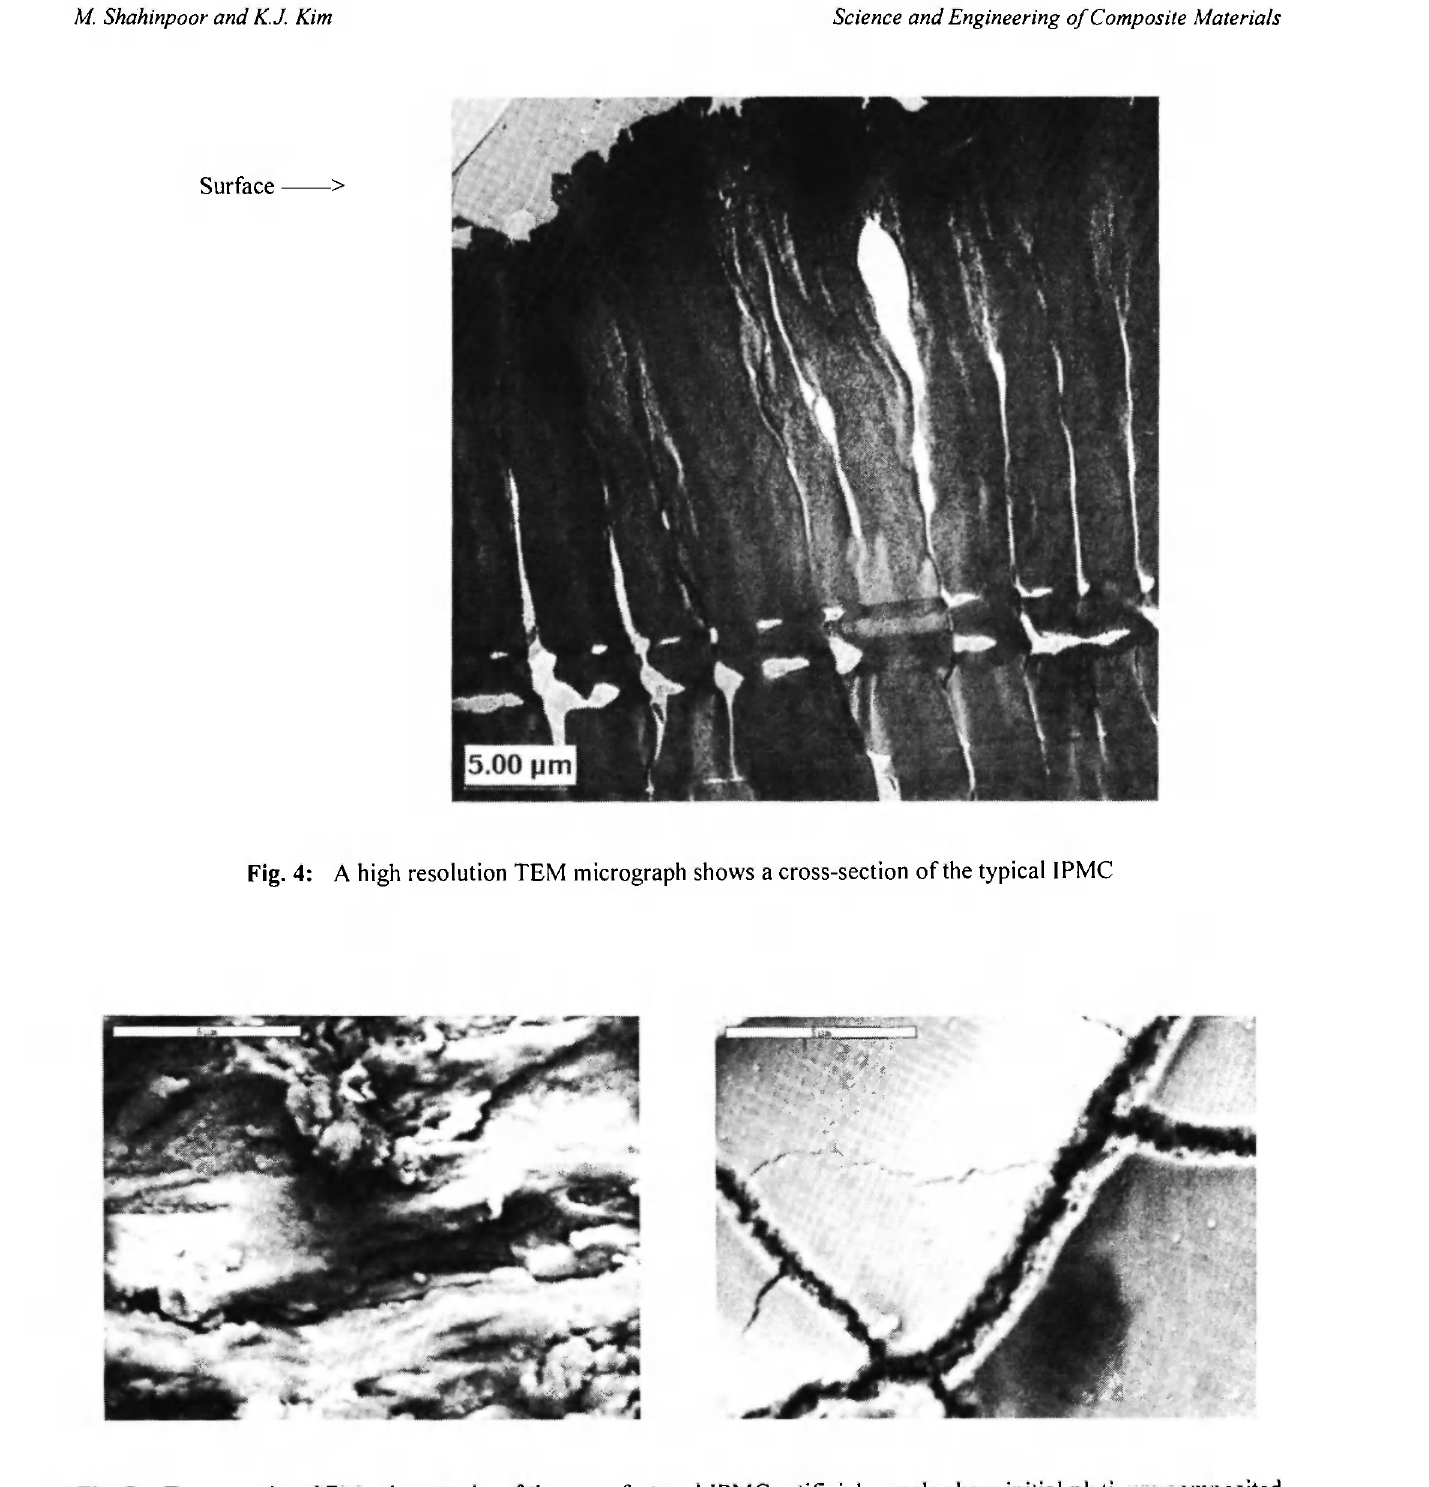
Fig. 5: Two top-view SEM micrographs of the manufactured IPMC artificial muscle show initial platinum composited within the membrane (left) and the subsequently loaded electrode on top of the initial Pt layer (right), respectively. Note that platinum concentration is predominant at the surface, meaning that they serve as particle